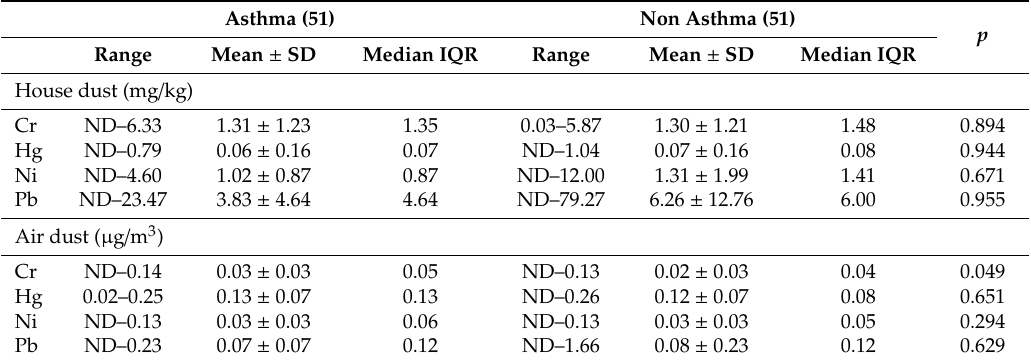
Table 4. Average concentrations of chromium (Cr), mercury (Hg), nickel (Ni), and lead (Pb) in house dust and airborne dust stratified by asthma status.